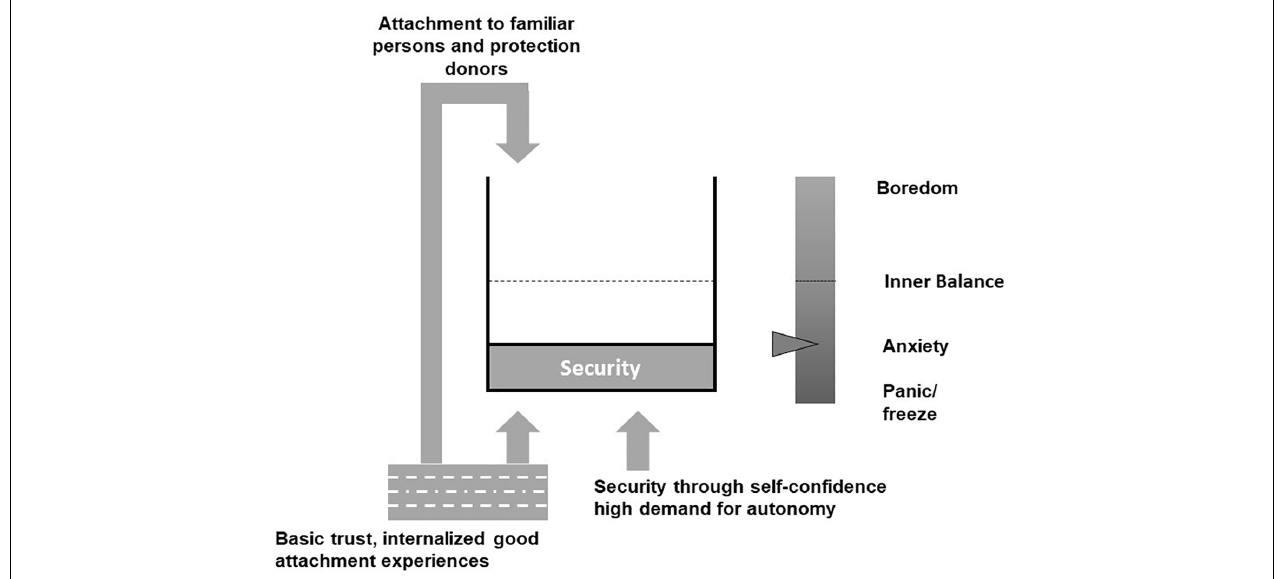
FIGURE 2 | Model of safety regulation modified according to Bischof (2008). The dashed line indicates the optimal level. Here, the person experiences no stress and is in emotional